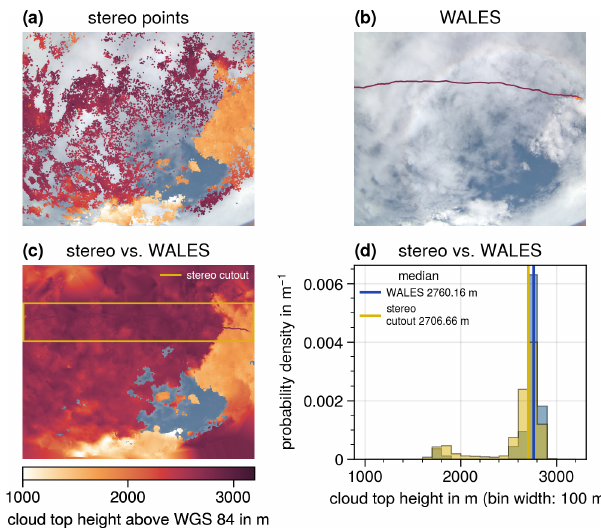
Figure 4. Cloud top height (CTH) information of the cloud field shown in Fig. 2 (2 February 2020, 16:47:45.07UTC). Panel (a) shows the CTH of stereo points from the stereographic reconstruc- tion method, panel (b) presents the CTH from the WAter vapour Lidar Experiment in Space (WALES) lidar system, and panel (c) shows the interpolated CTH based on the stereo points. The WALES CTH is plotted on top (hardly visible due to the similarity to the CTH from the stereo points). The stripe marked by the yellow lines indicates a specMACS cutout surrounding the WALES track. Panel (d) shows the probability densities of the CTHs of the specMACS cutout (yellow) and the WALES measurements (blue). The RGB measurement of the cloud field is shown in the background of pan- els (a) , (b) , and (c) . The color bar below panel (c) corresponds to all cloud top height measurements shown in panels (a) , (b) , and (c)